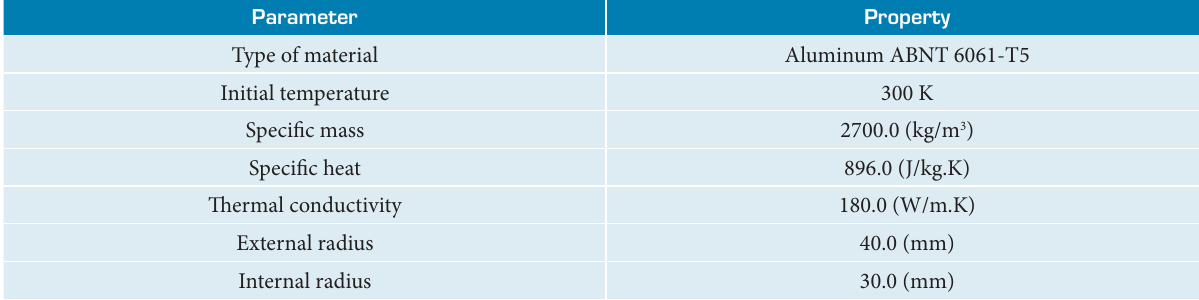
Table 1. Physical properties hypothetic problem.